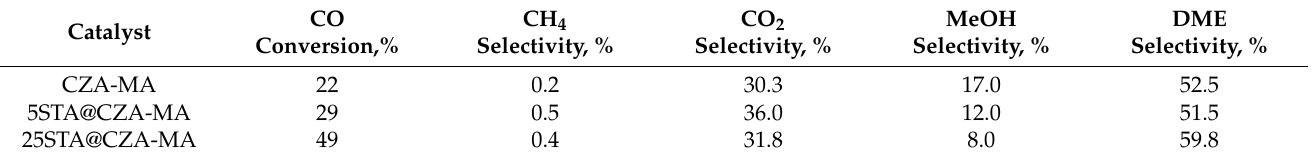
Table 2. Activity Test Results of the STA incorporated core-shell catalysts (T = 275 ◦ C; P = 50 bar; CO/H 2 :1/1 as feed stream) (Duration of reaction period: 200